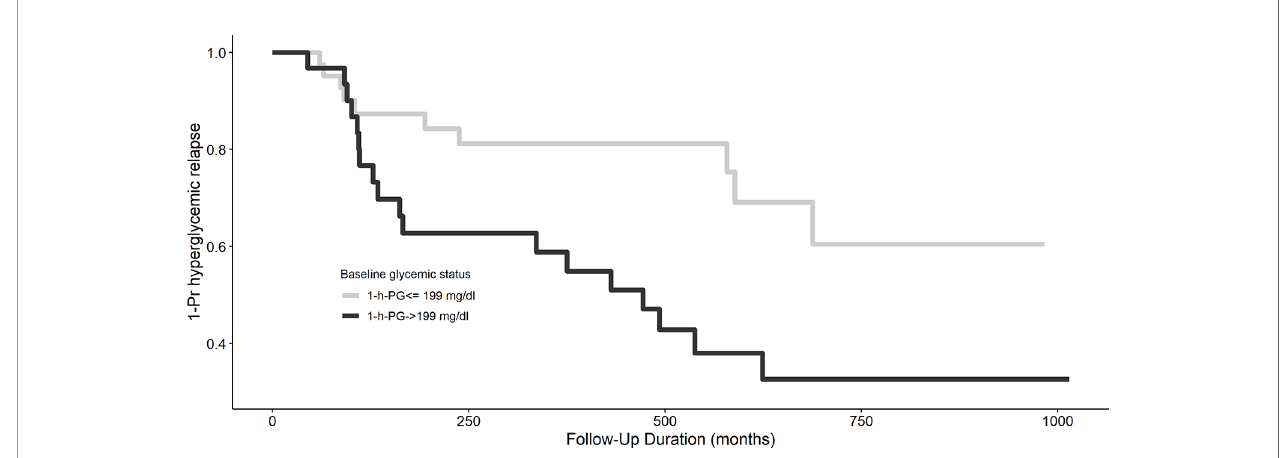
FIGURE 1 | Kaplan – Meier curve of hyperglycemia relapse based on 1-h plasma glucose challenge categories. A 1-h plasma glucose challenge level ≥ 199 mg/dl is associated with longer hyperglycemia relapse-free survival, p =